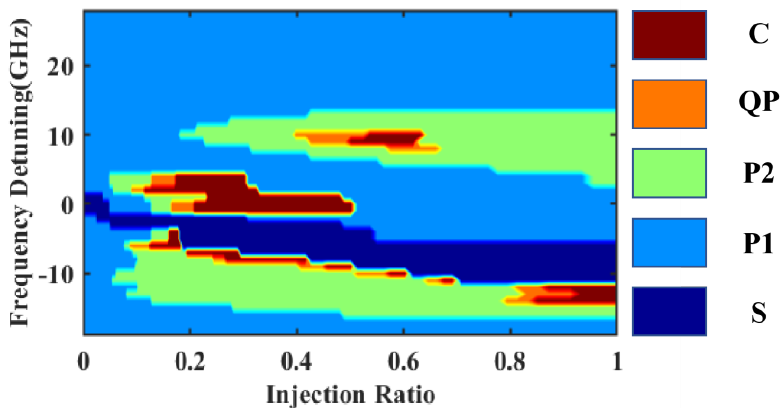
1 and − 16 GHz < Δ f < − 8 GHz and 0.1 < ξ inj < 1 are larger than those in DFB lasers [28], but and − 16 GHz < ∆ f < − 8 GHz and 0.1 < ξ inj < 1 are larger than those in DFB lasers [28], but P1 dynamic still dominates on the region above the Hopf bifurcation line. P1 dynamic still dominates on the region above the Hopf bifurcation line. P1 dynamic still dominates on the region above the Hopf bifurcation line.